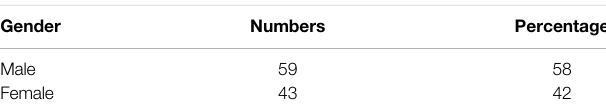
TABLE 2 | Gender of respondents. TABLE 3 | Domains of respondents.